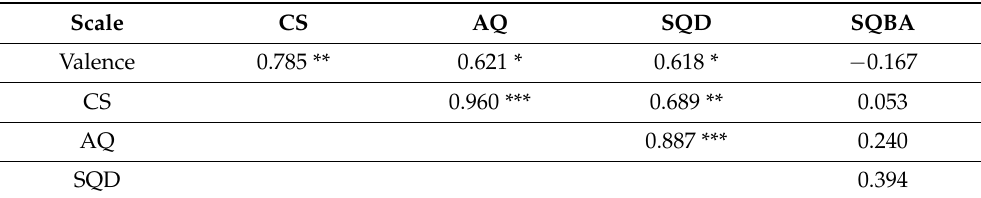
Table 3. Correlations ( n =